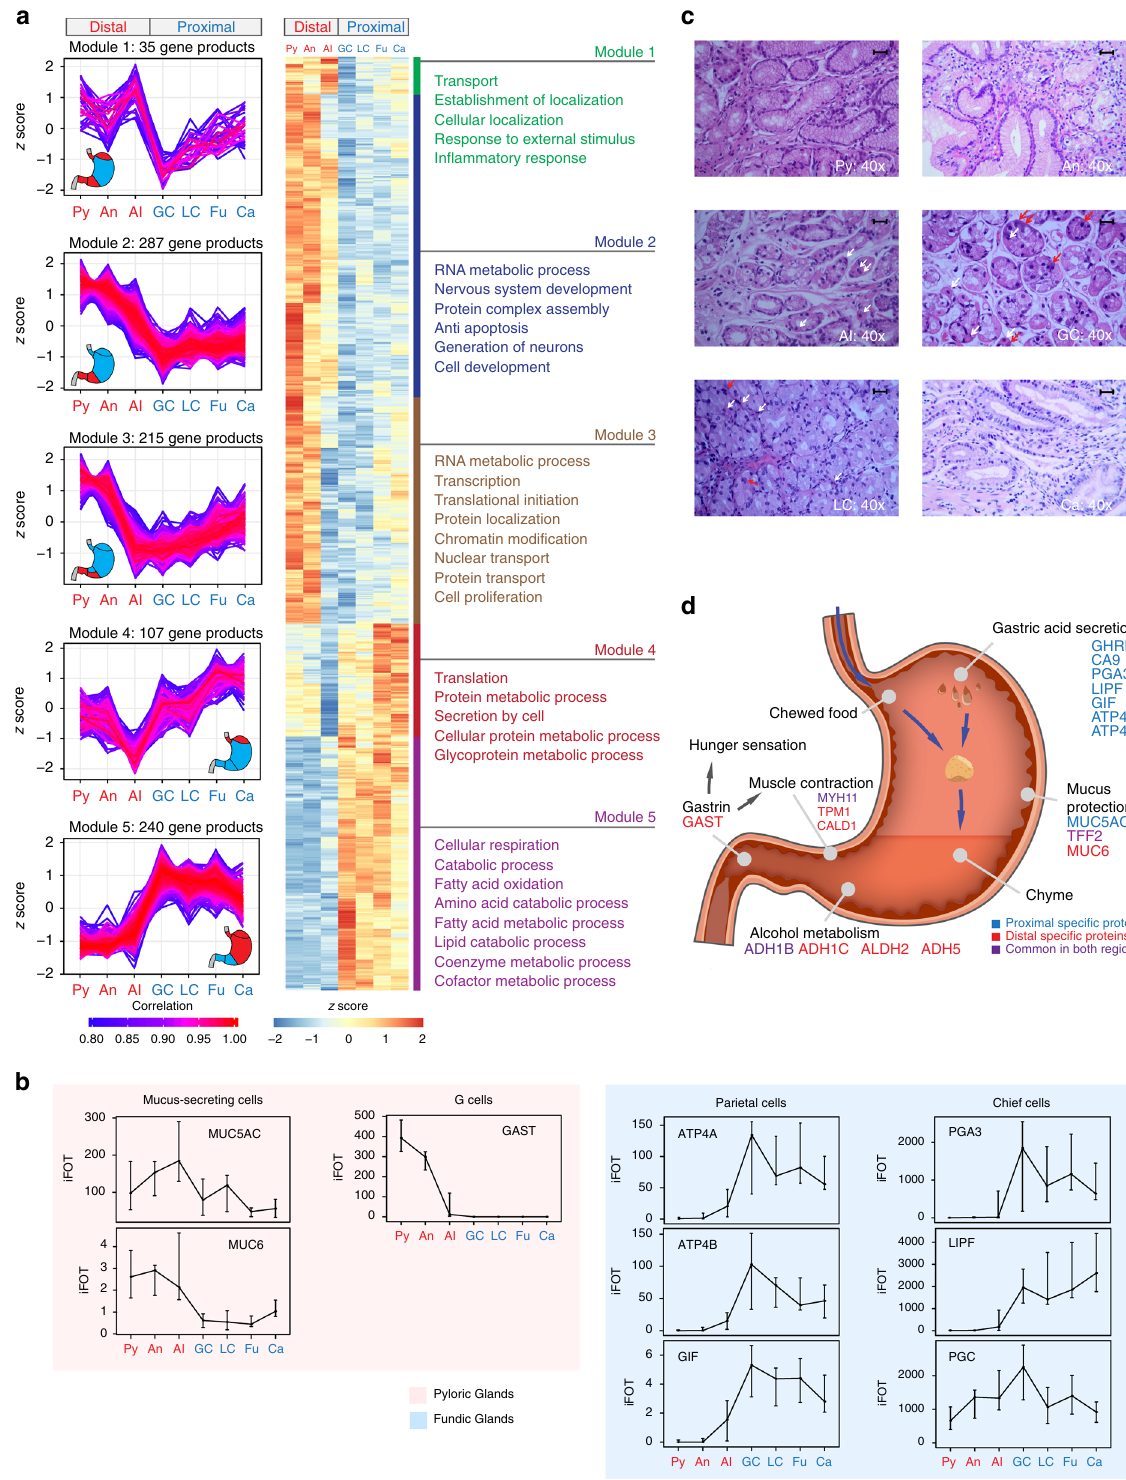
Fig. 3 Region-speci fi c protein modules and functional differences. a Five gene modules revealed by co-expression analysis. Left panel: The co-expression patterns of the proteins in the fi ve module; right panel: representative GO terms of each module. b Relative protein abundances of four gastric cell markers across 7 regions (Py: n = 10, An: n = 10, AI: n = 15, GC: n = 12, LC: n = 11, Fu: n = 12, Ca: n = 12). Mean ± SD. c Hematoxylin – eosin (H&E) staining of mucosa tissues from different stomach regions, indicating the chief cells and parietal cells are mainly found in AI, GC, and LC regions. Red arrows: chief cells; white arrows: parietal cells. Scale bar: 100 μ m. d A schematic diagram of the structure and functions of the human stomach